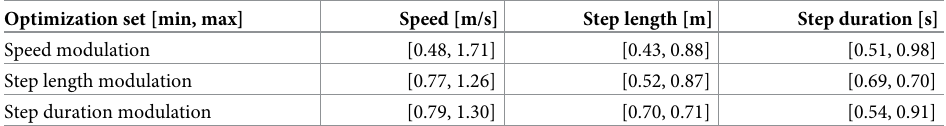
Table 4. Boundaries of the three gait measures reached with the optimization of key reflexes. The optimization of the key reflexes alone could obtain the same performances of the gaits obtained optimizing all the reflexes suggesting that the major role of modulation is delegated to the key